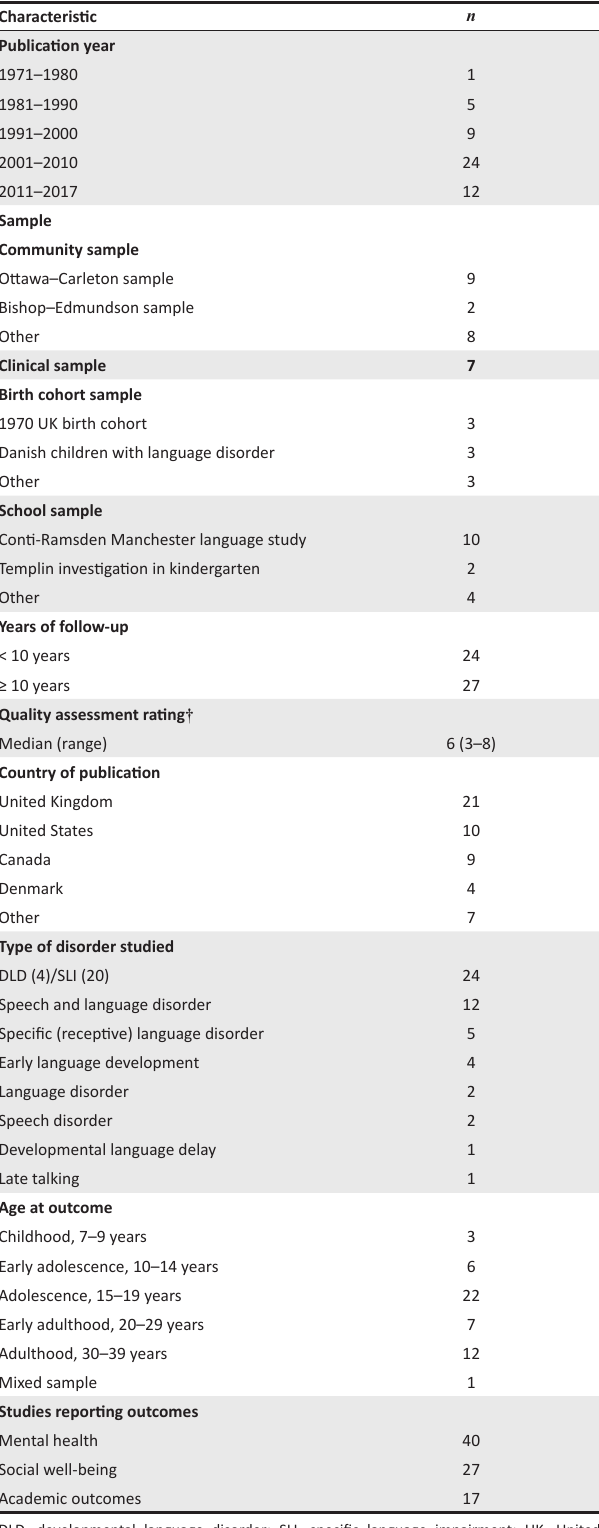
TABLE 1: Study characteristics ( n =